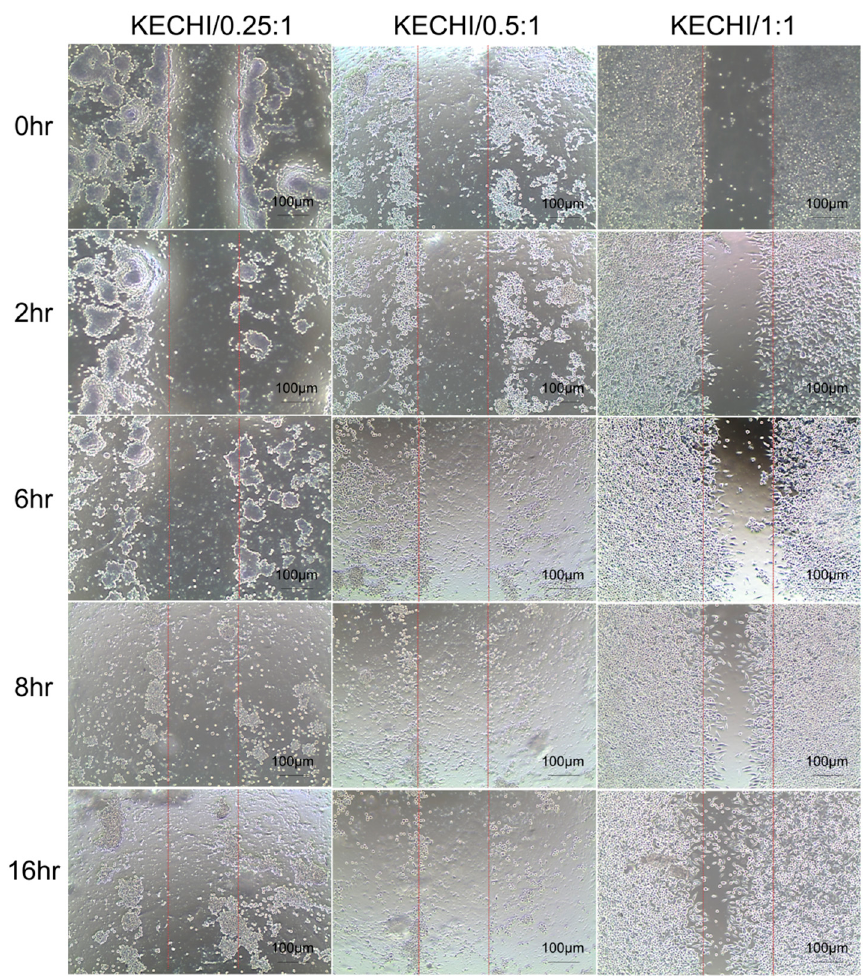
Figure 8. Effects of different types of keratin-chitosan membranes on cell migration of L929 cells. After removing the Culture-Insert well mold, the cell-free zones were photographed at 0 h, 2 h, 6 h, 8 h, and 16 h.